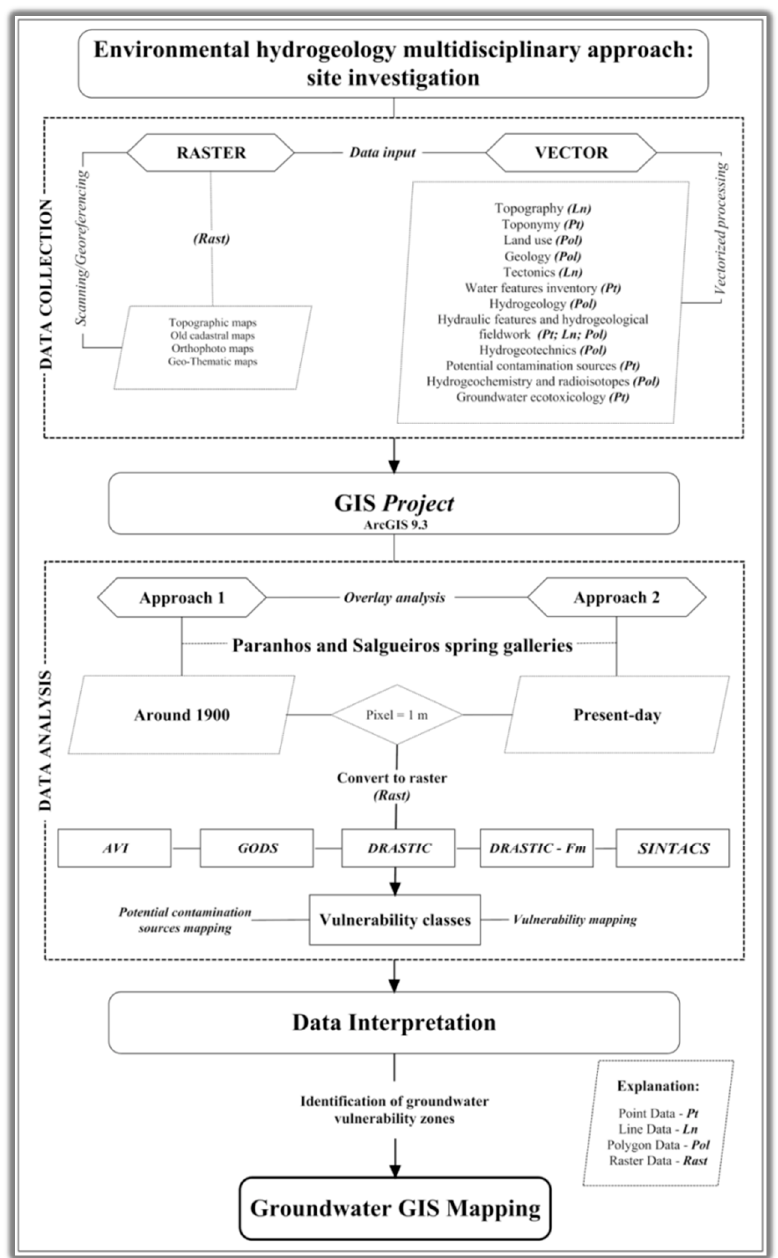
Figure 1. Flowchart of the GIS ‐ based methodology applied to the study of Paranhos and Salgueiros spring galleries.